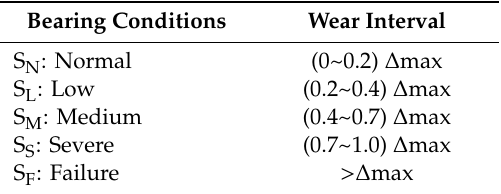
Table 3. Wearing conditions of